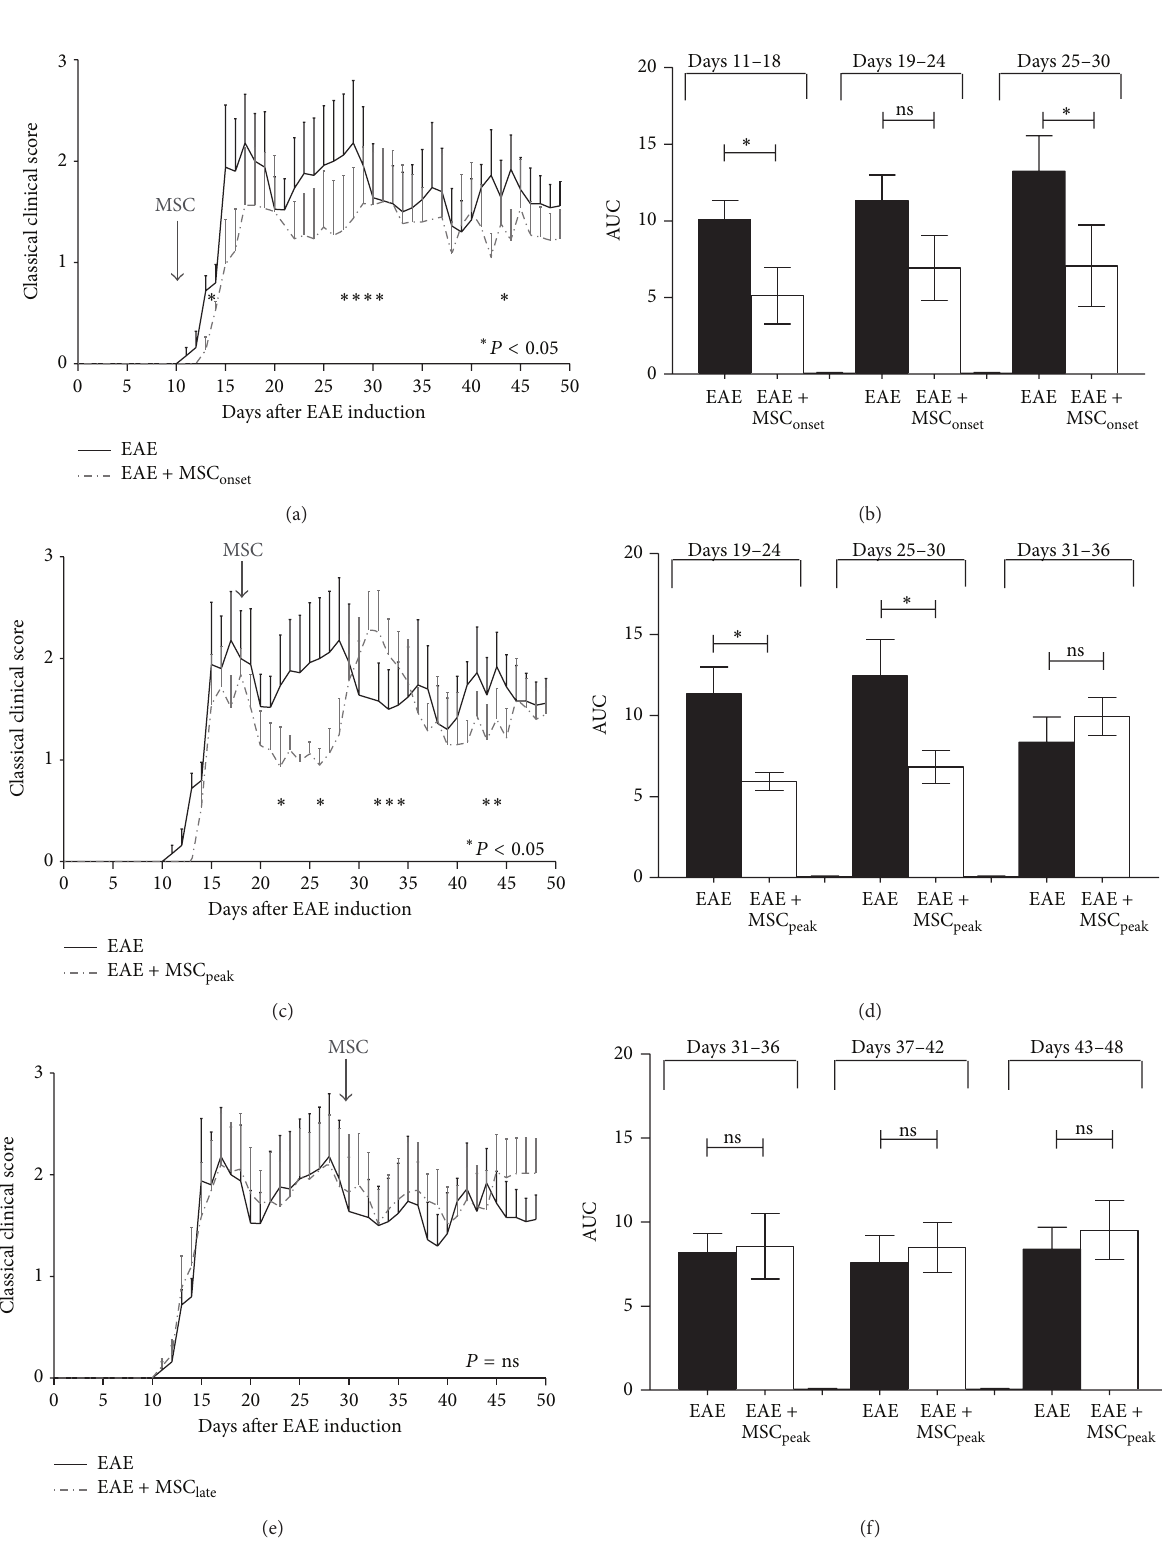
Figure 3: MSCs injections at the onset and at the peak of disease induce an improvement of classical EAE. C57BL/6 mice were immunized with MOG 35−55 to induce EAE and classical score was evaluated daily. MSCs (1 × 10 6 ) were intravenously injected either at (a, b) the onset of ), (c, d) at the peak of the disease (EAE + MSC ), or (e, f) at the time of EAE stabilization (EAE + MSC ). EAE symptoms (EAE + MSC onset peak late Daily clinical score (a, c, e) and the area under curve (AUC) (b, d, f) parameters were evaluated after MSCs injection as described in Methods and AUC were plotted at specific time periods as indicated. Line curves and bars represent the mean ± SEM; statistical differences were calculated using Mann-Whitney test ( ∗ 𝑃 < 0.05 ), 𝑛 = 7